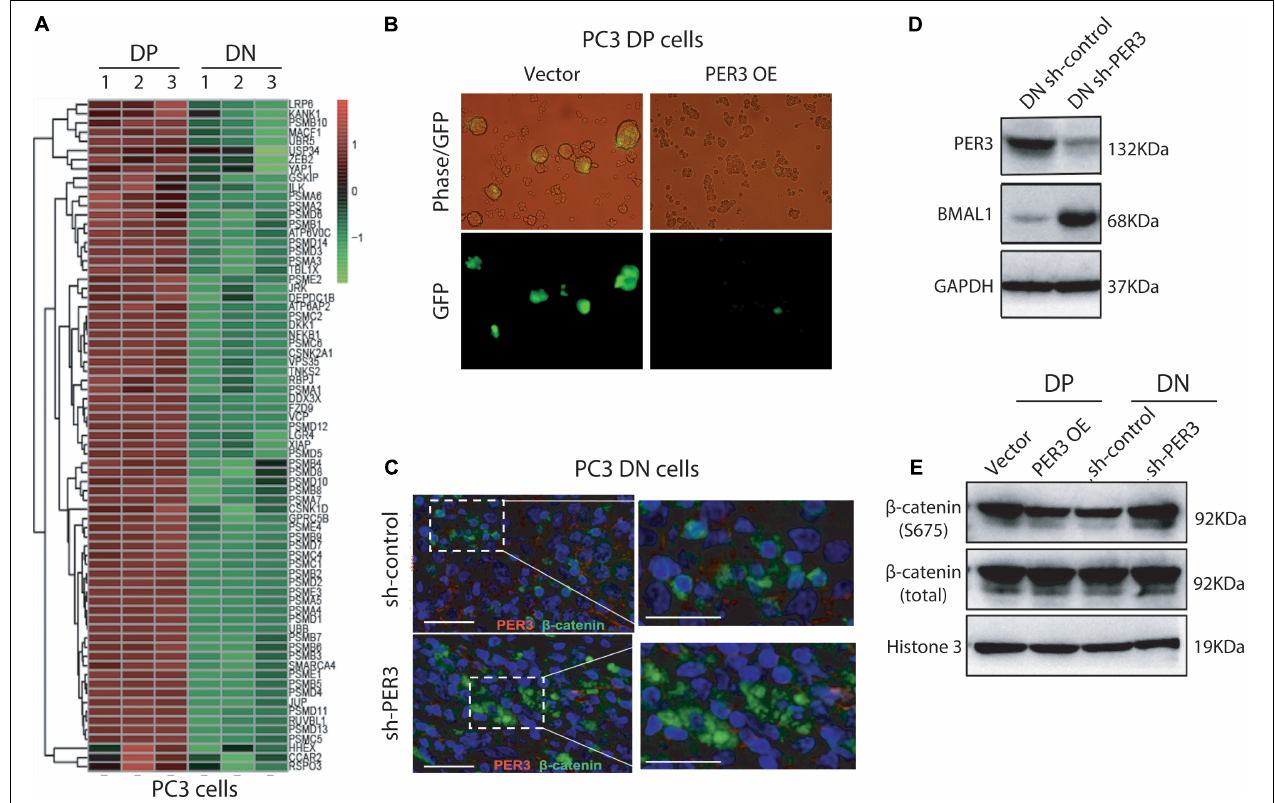
FIGURE 6 | Low levels of PER3 activate WNT/ β -catenin pathway. (A) Heatmap enrichment of genes associated with WNT/ β -catenin signaling pathway in PC3 DP cells and PC3 DN cells. (B) Representative images showed TOP-GFP expression in PC3 DP cells transfected with the TOP-GFP lentivirus vector. Scale bars, 100 µ m. (C) Immunofluorescent staining of PER3 and β -catenin in PC3 DN cells after PER3 KD revealed that PER3 KD promoted translocation of β -catenin from cytoplasm into nucleus. Scale bars, left: 100 µ m, right: 200 µ m. (D) PER3 KD in PC3 DN cells led to the upregulation of BMAL1. Shown are western blotting of the molecules indicated. GAPDH was used as the control. (E) PER3 OE in PC3 DP cells resulted in the downregulation of phosphorylated β -catenin expression level, but PER3 KD in PC3 DN cells upregulated levels of phosphorylated β -catenin. GAPDH was used as the loading control at the western